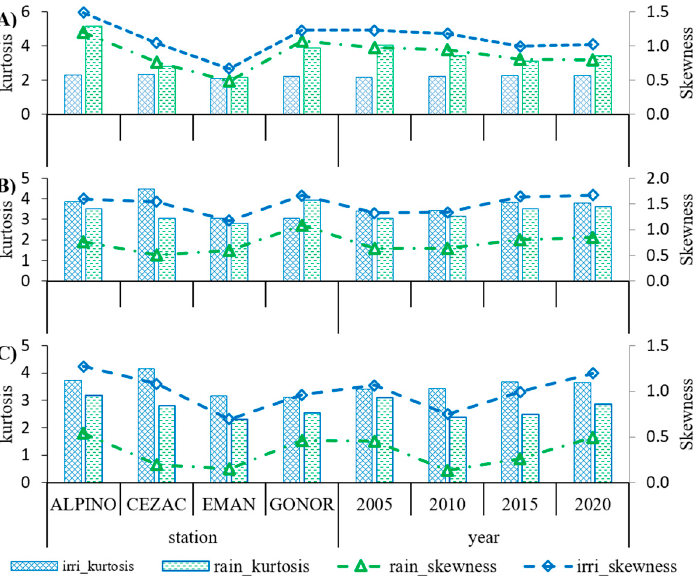
Figure 3. Kurtosis (bars) and skewness (lines) of the output variables: ( A ) thermal time, ( B ) biomass and ( C ) yield of the SIMPLE model in trials between weather stations and between bean production years in Zacatecas,